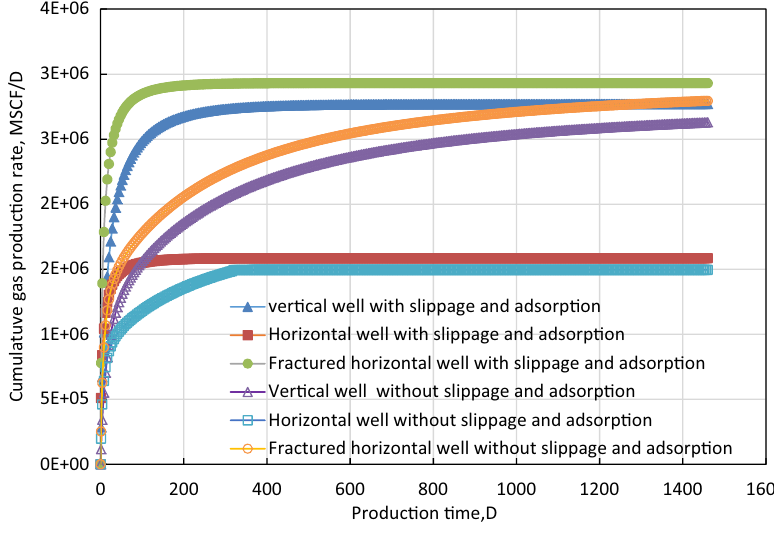
Fig. 10 Comparison of performance of different type of wells and fractured wells in shale gas reservoirs (vertical well, horizontal well, fractured horizontal